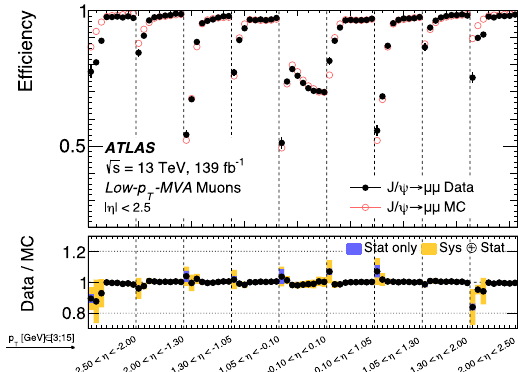
each η bin with p T increasing from 3 to 15 GeV going from left to right. When not negligible, the statistical uncertainty in the efficiency mea- surement is indicated by the error bars. The panel at the bottom shows the ratio of the measured to predicted efficiencies, with statistical and systematic